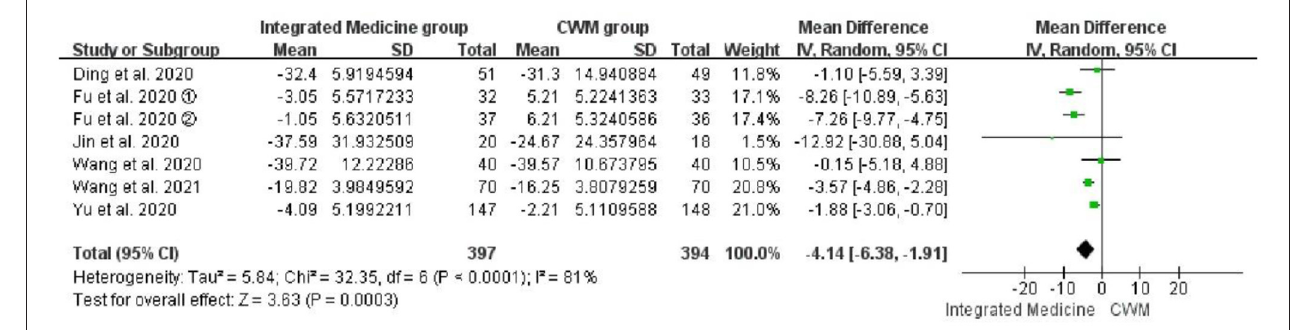
FIGURE 6 | Forest plot of CRP (mg/L).